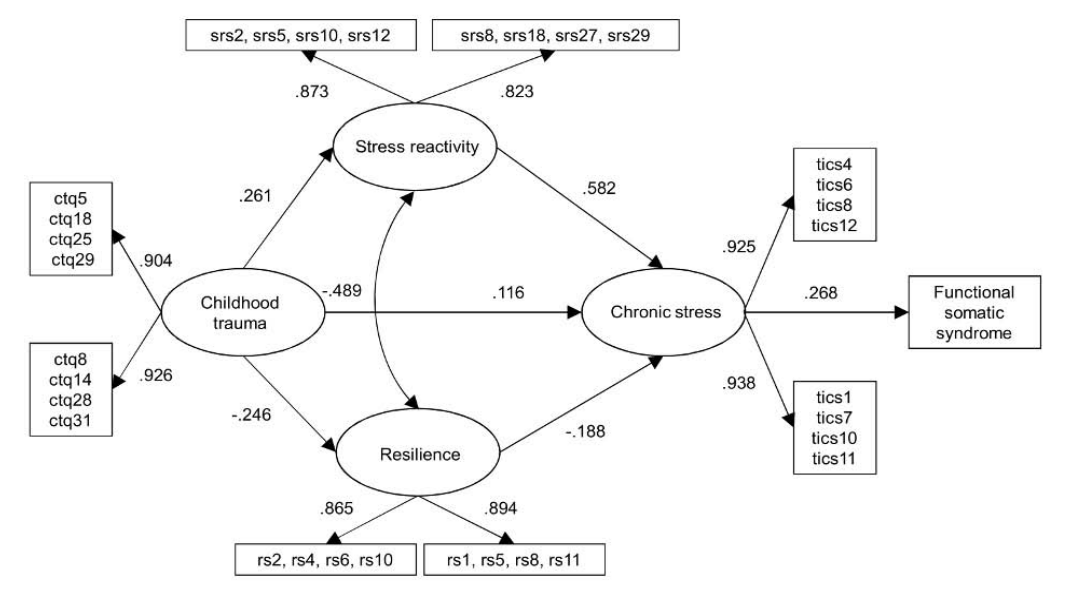
Figure 2. Cross-sectional path analysis model: FSS on chronic stress including standardized path coefficients. ctqx = Childhood Trauma Questionnaire, indicator x. srsx = Stress Reactivity Scale, indicator x. rsx = Resilience Scale, indicator x. ticsx = Trier Inventory for the Assessment of Chronic Stress, indicator x.